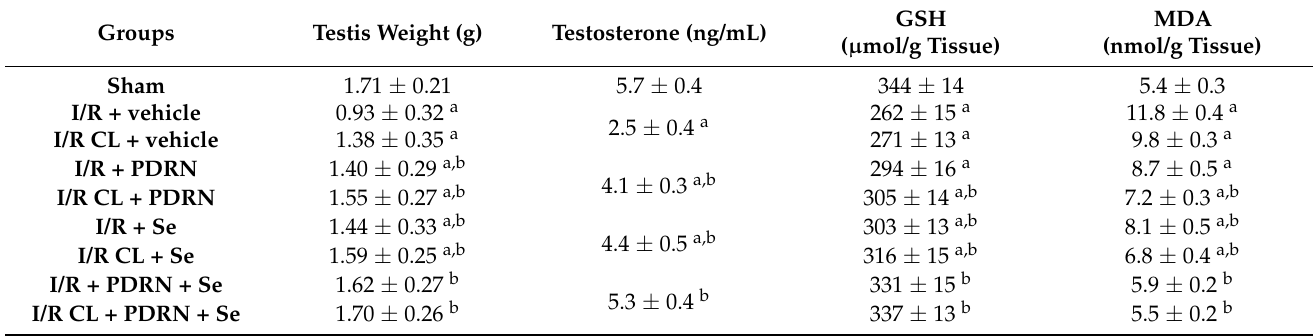
Table 1. Effects on testis weight, testosterone, glutathione, and malondialdehyde levels induced by PDRN and Se alone or in association in testes of I/R rats compared with ischemia-reperfusion and sham rats. All values are expressed as mean ± SD; n = 7